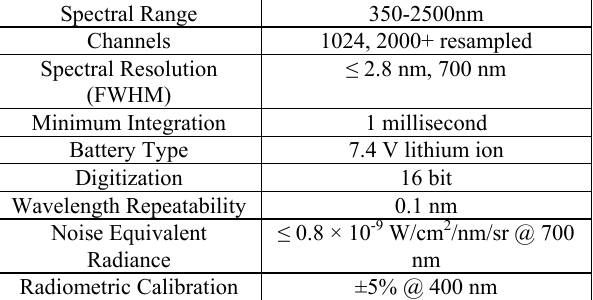
Table 6.Specifications of SVC XHR-1024 spectro-radiometer